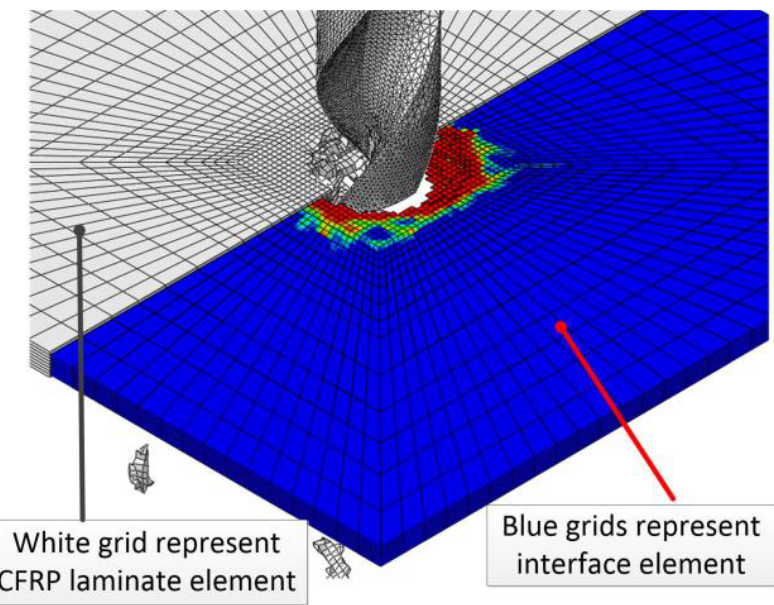
Figure 2. Finite element simulation results of CFRP three-dimensional drilling.